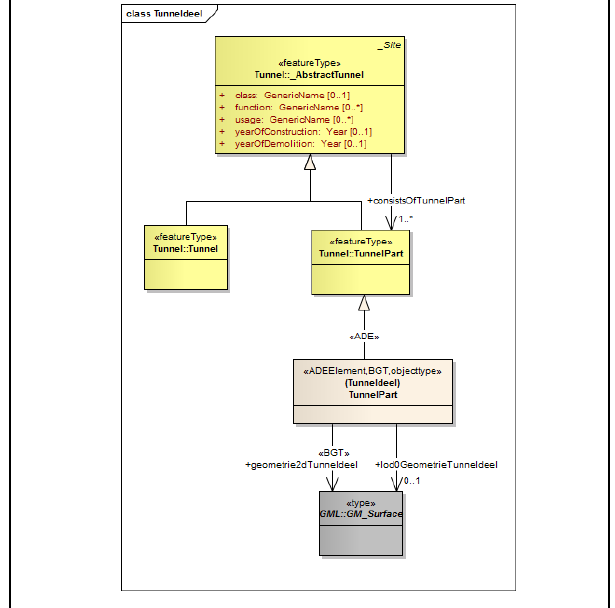
Figure 1: TunnelPart AD Element with 2D